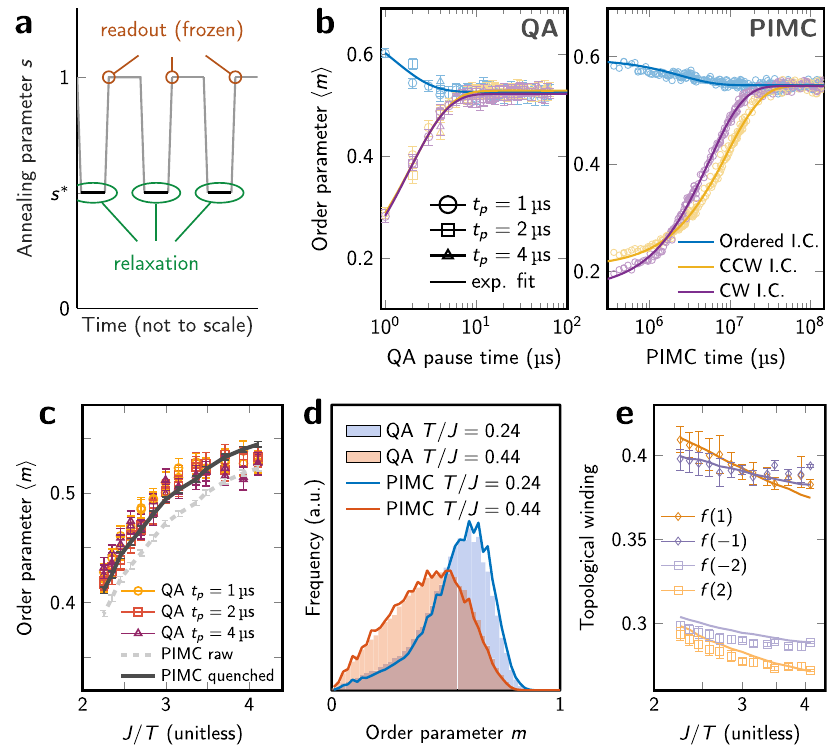
Fig. 2 Convergence of statistical estimates for 1440-spin lattice. a The QA protocol alternates between equilibration and readout, forming a chain of annealing cycles, each containing a pause of length t p during which relaxation occurs in the simulated model, parameterized by s * (Supplementary Information). This breaks the simulation into discrete units, allowing observation of QA equilibration as in the Markov-chain PIMC simulation. b Starting (cid:3) (cid:4) from ordered, CCW, and CW initial conditions (Fig. 1), time-dependent QA and PIMC estimates of the order parameter m ð t Þ converge to terminal values m h i for parameters Γ / J = 0.736 and T / J = 0.244. Fit lines show exponential convergence to equilibrium from each initial conditions. c QA estimates of m h i closely agree with quenched PIMC results (with local excitations removed) over a range of temperatures for Γ / J = 0.736, for two mappings of the lattice onto the QA processor. We attribute the underestimate of 0.01 at low temperatures to disorder in the Hamiltonian (Supplementary Information). d Histograms of m at high and low temperatures for Γ / J = 0.736 show accurate simulation of the entire distribution. e Topological winding from higher- order Fourier weights (Supplementary Information) shows that QA accurately simulates a subtle temperature-dependent preference between CCW (positive) and CW (negative) winding (lines = PIMC, symbols = QA). All error bars are 95% con fi dence interval on the mean.